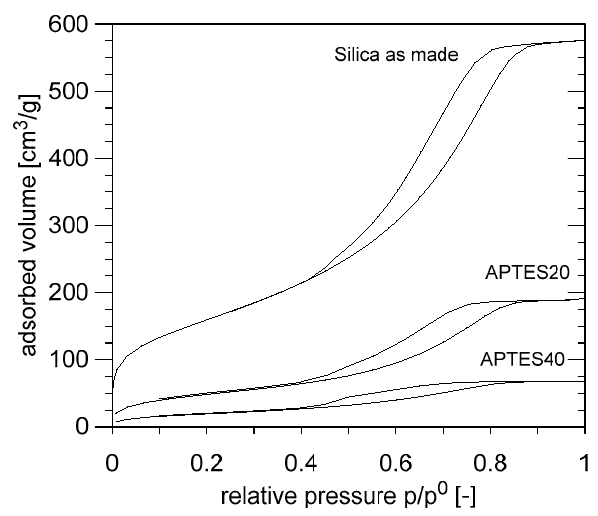
Figure 5. Nitrogen adsorption–desorption isotherms for the as-made silica and two amino- functionalized samples.